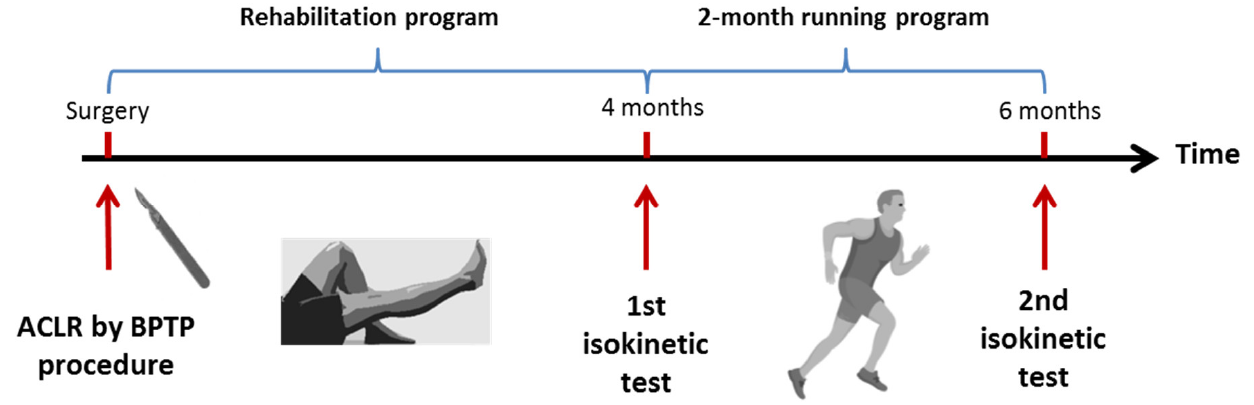
Figure 1. Experimental scheme of the study.